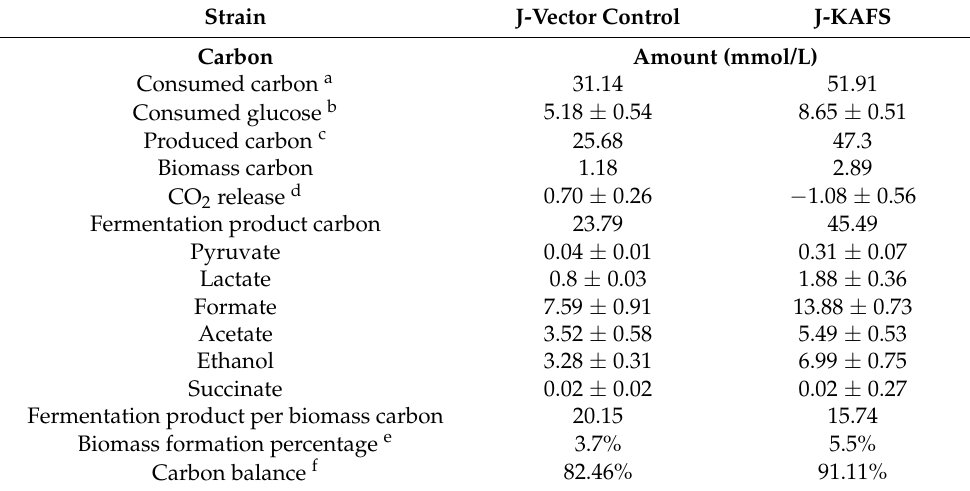
Table 3. The carbon balance of transgenic E. coli